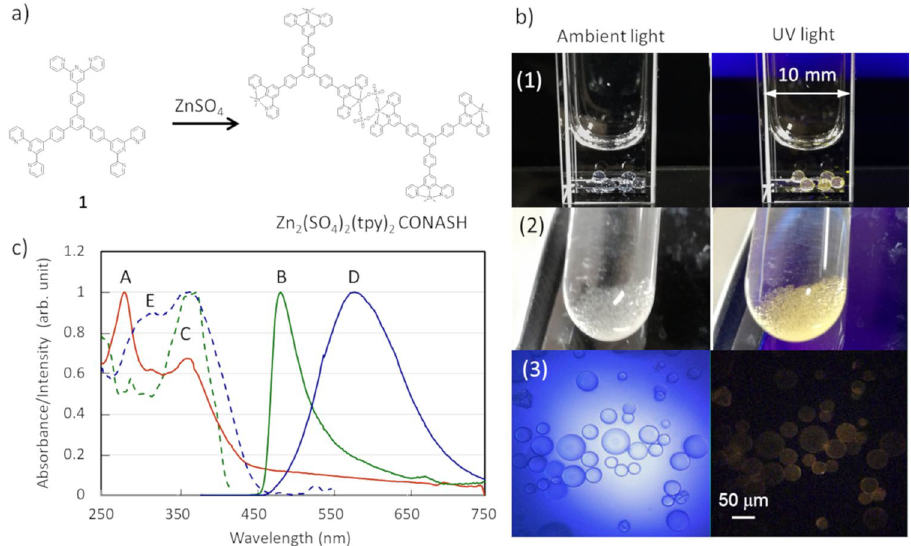
Figure 5. Zn 2 (SO 4 ) 2 (tpy) 2 CONASH capsules. ( a ) Synthesis of Zn 2 (SO 4 ) 2 (tpy) 2 CONASH capsules. ( b ) Photographs and microscope images of Zn 2 (SO 4 ) 2 (tpy) 2 CONASH capsules obtained by the dropping method (1) and by the emulsion method (2, 3) under ambient and 365 nm UV light. ( c ) Absorption (A), emission (B) and excitation (C) spectra of Zn 2 (SO 4 ) 2 (tpy) 2 CONASH capsules in DCM, and emission (D) and excitation (E) spectra of Zn 2 (SO 4 ) 2 (tpy) 2 CONASH capsules in